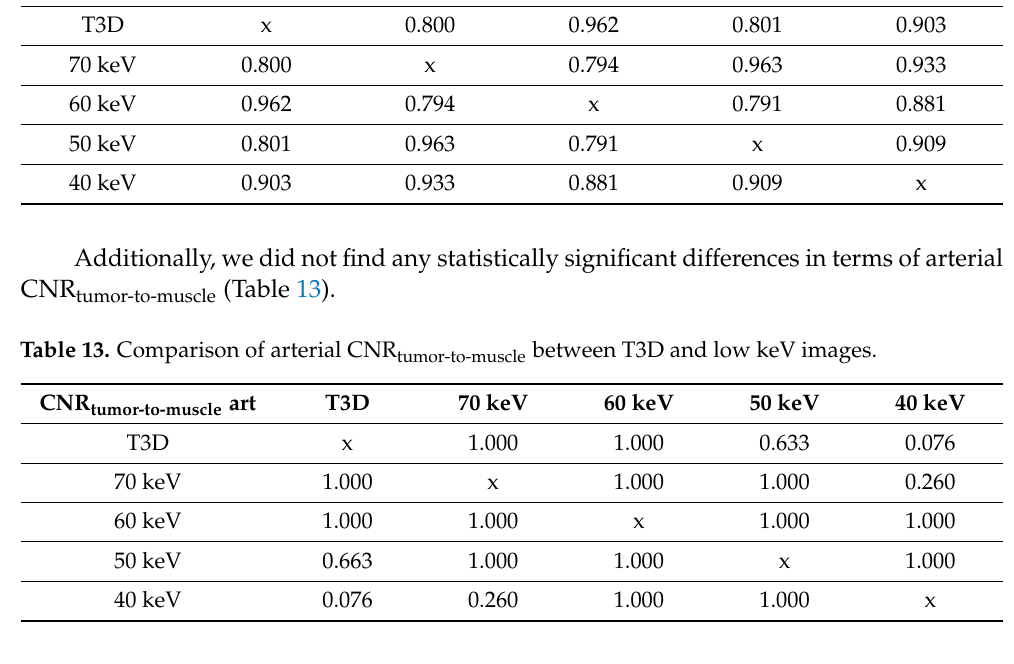
Table 12. Comparison of portal venous CNR tumor-to-liver between T3D and low keV images. CNR tumor-to-liver T3D 70 keV 60 keV pv